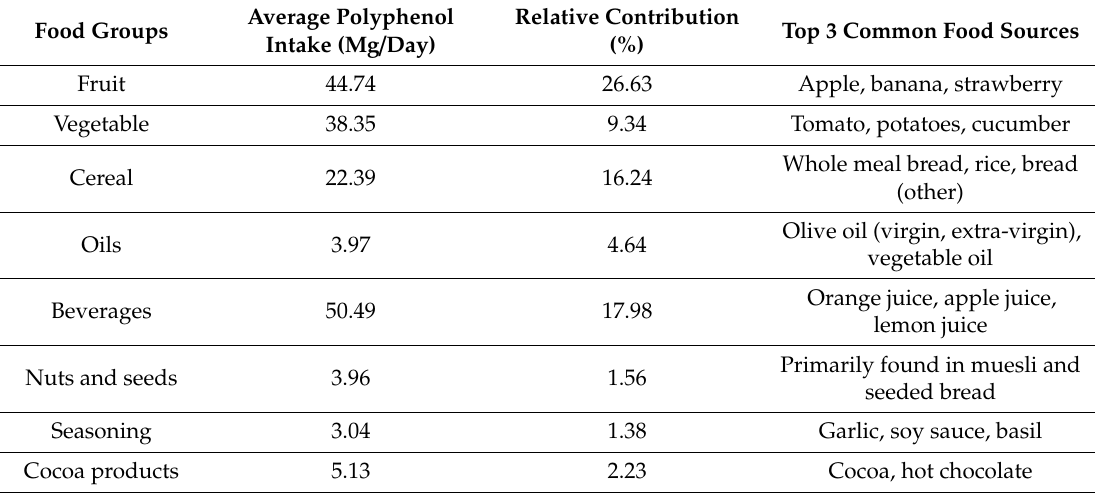
Table 3. Contributions of polyphenols from each food group and food sources.